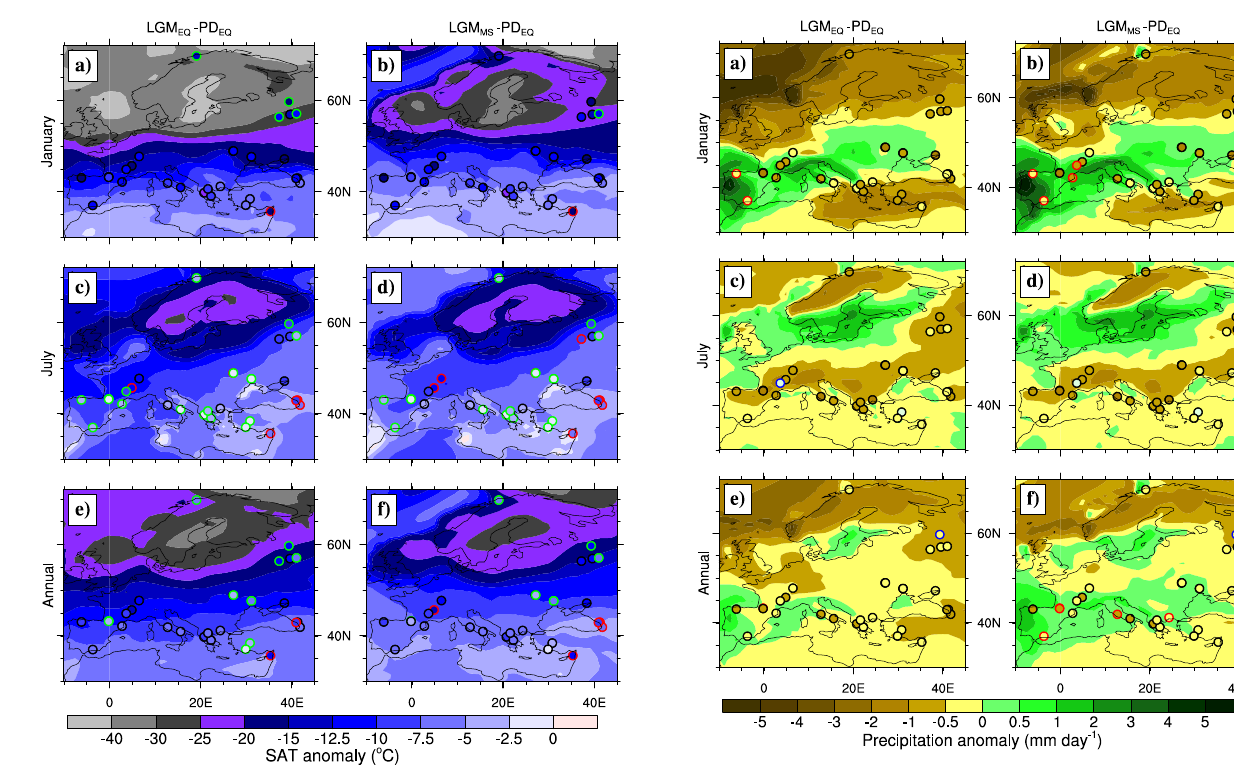
Fig. 3. As Fig. 2, but for precipitation. Fig. 2. SAT anomalies with respect to PD EQ for LGM EQ (left) and LGM MS (right) for the coldest month (January, a and b ), the warmest month (July, c and d ), and the annual mean ( e and f ). The colored circles are estimated temperature anomalies based on proxy data (Wu et al., 2007) with a red (green) border indicating significantly stronger (weaker) negative anomalies than at the closest grid cell of the model (outside the 90% confidence interval of Wu et al., 2007).